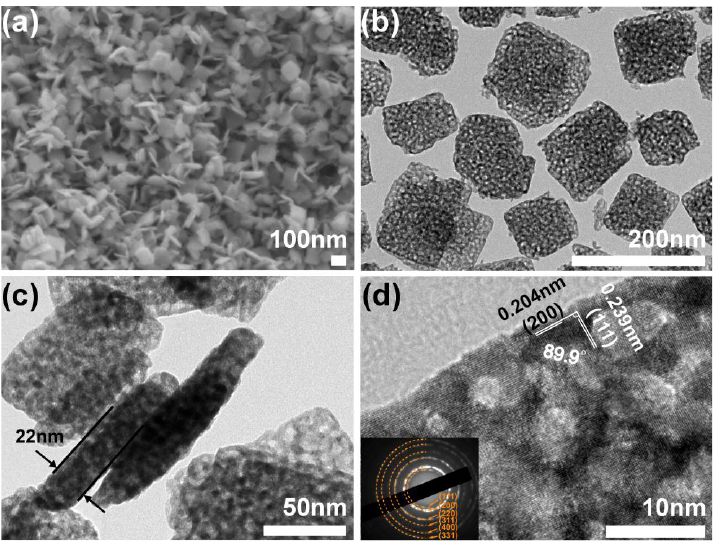
Figure 1. ( a ) Powder X-ray diffraction (XRD) patterns of tungsten oxide hydrate (WO 3 ·H 2 O) A, tungsten nitride (WN) B and hybrid tungsten nitride and oxide (WN/WO 3 ) composites C; ( b ) differential scanning calorimetry-thermal gravimetric analysis (DSC-TGA) curves of WN/WO 3 composites.